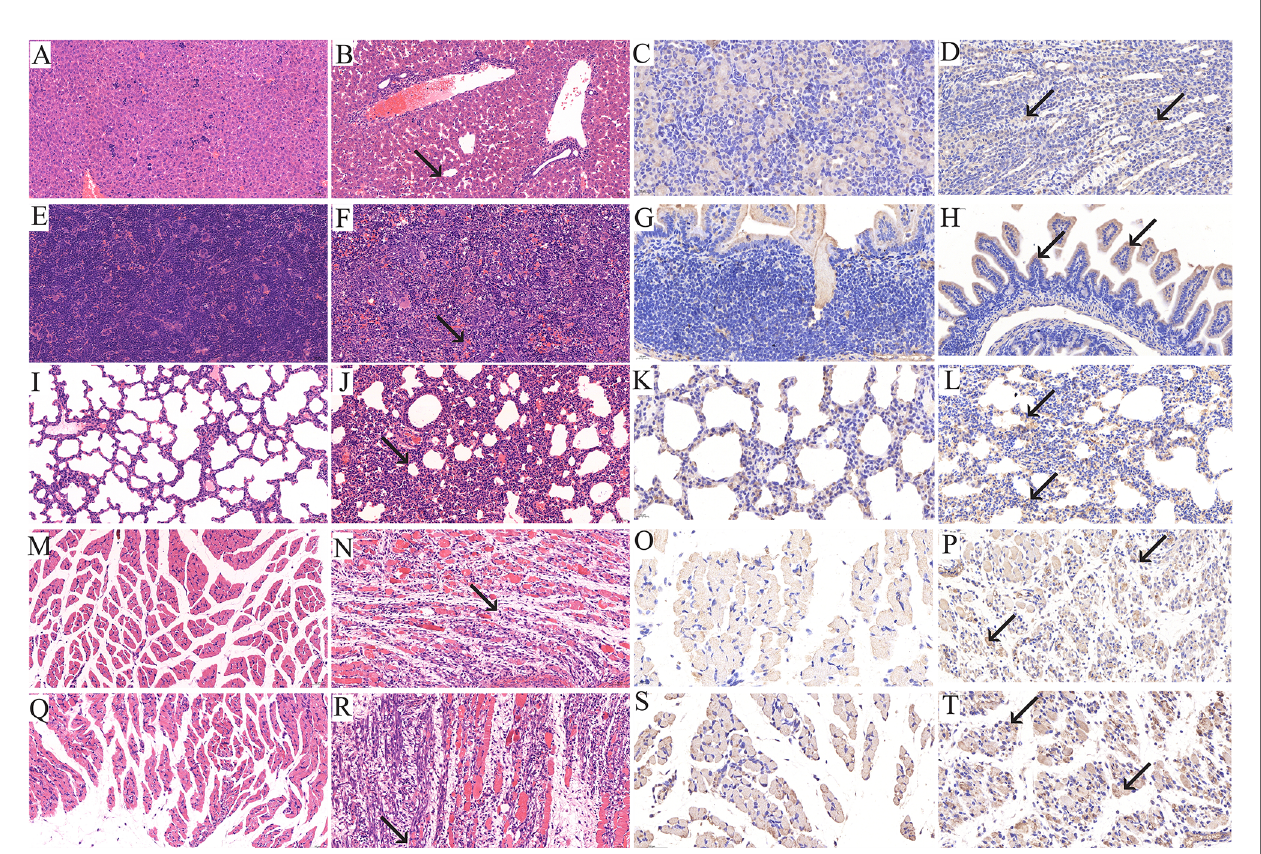
FIGURE 5 | Histopathological (×200) and immunohistopathological analyses of tissues isolated from CVA6-infected neonatal mice (×400). One-day-old BALB/c mice were intracranially injected with 5.5 lgCCID 50 of the KYN-A1205 strain or an equal volume of uninfected cell supernatant. Obvious histological changes in the liver, spleen, lung, forelimb muscle and hindlimb muscle tissues of the experimental group ( B, F, J, N, R , black arrow) were noted. No histological changes were observed in the liver, spleen, lung, forelimb muscle and hindlimb muscle tissues of the negative control group (A, E, I, M, Q) . The CVA6 antigen was detected in the liver, lung, intestine, forelimb muscle and hindlimb muscle tissues of the experimental group ( D, H, L, P, T , black arrow). No antigen was detected in the liver, lung, intestine, forelimb muscle and hindlimb muscle tissues of the negative control group (C, G, K, O, S)